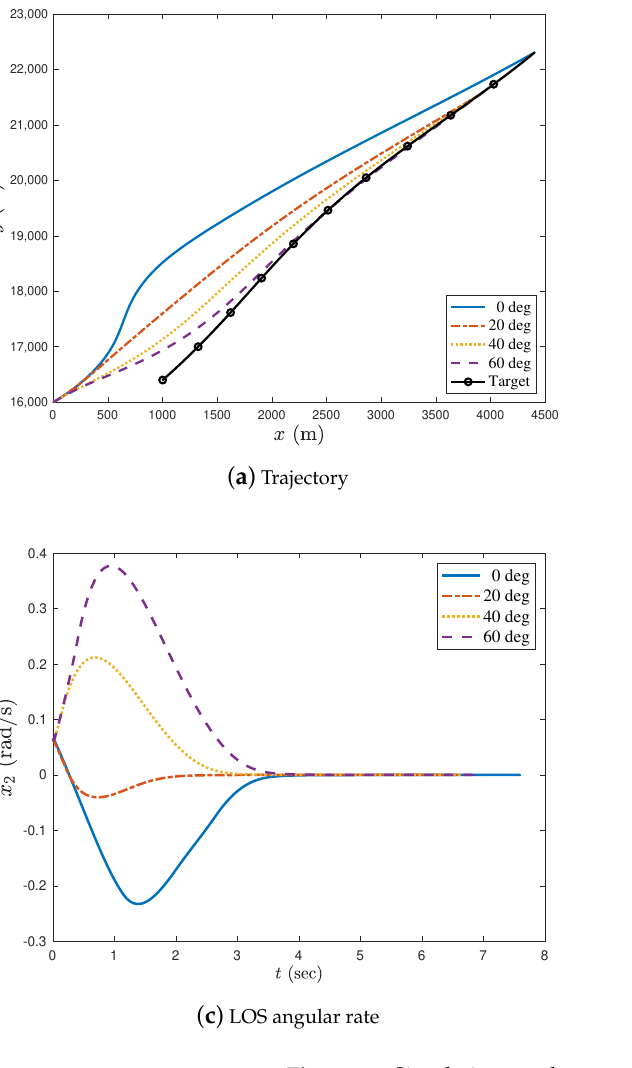
Figure 11. Simulation results at q d = 0,5,30,60 deg with the target acceleration a t = 7gcos ( π /4 )